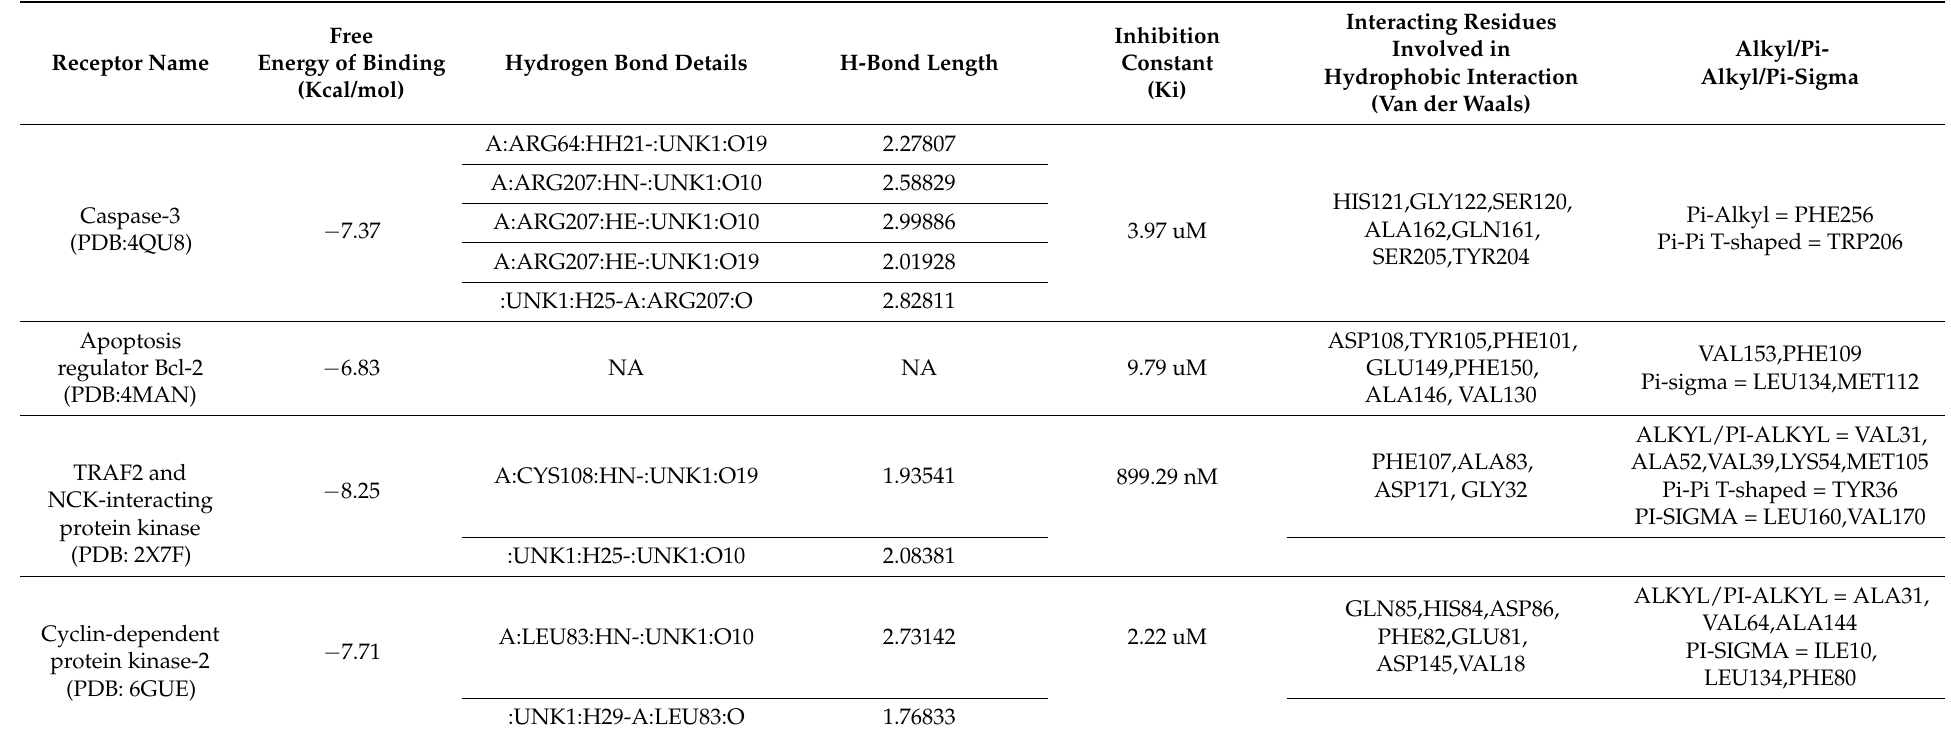
Table 2. Showing docking results of chrysophanol with receptor molecules caspase-3, apoptosis regulator Bcl-2, TRAF2 and NCK-interacting protein kinase and cyclin-dependent protein kinase